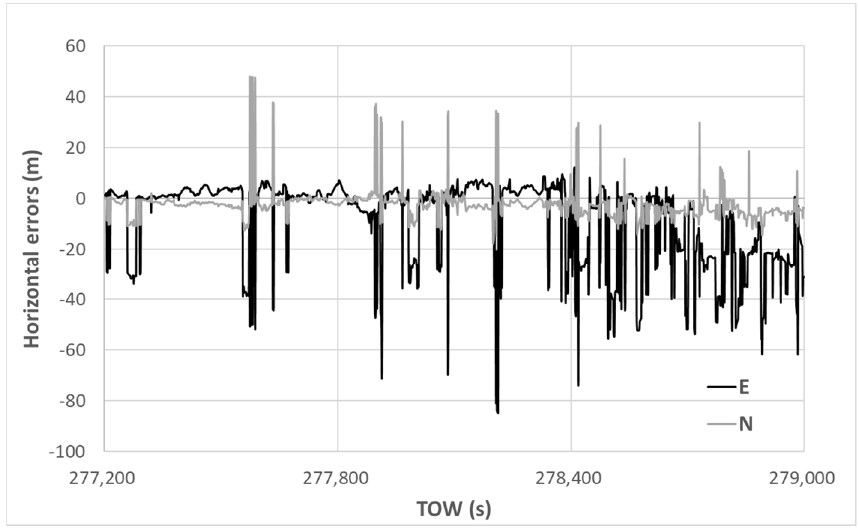
Figure 14. DGNSS horizontal errors.